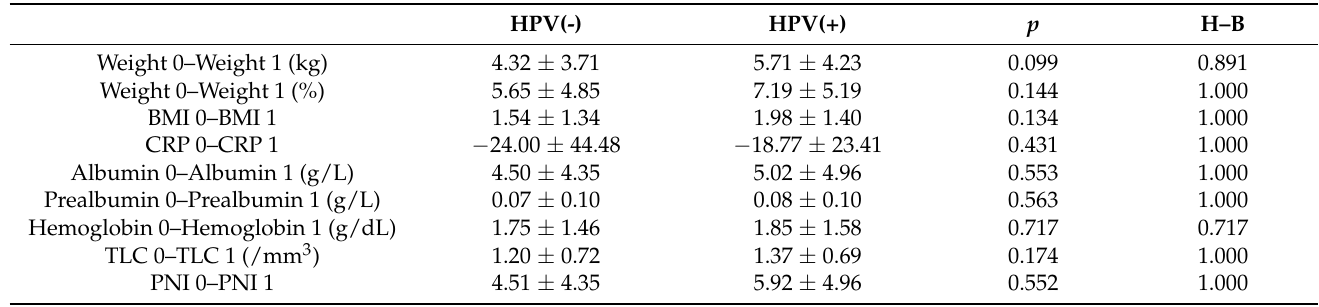
Table 3. Weight, BMI, and laboratory results: differences before (0) and after treatment (1) between the HPV(-) and HPV(+)